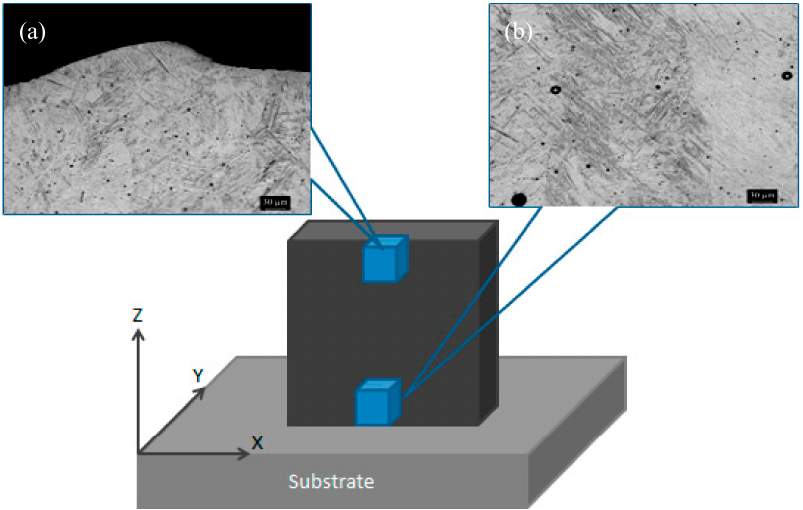
Figure 32. OM micrographs of a Ti-6Al-4V sample produced via LP-DED process from the ( a ) top to the ( b ) bottom region [130].